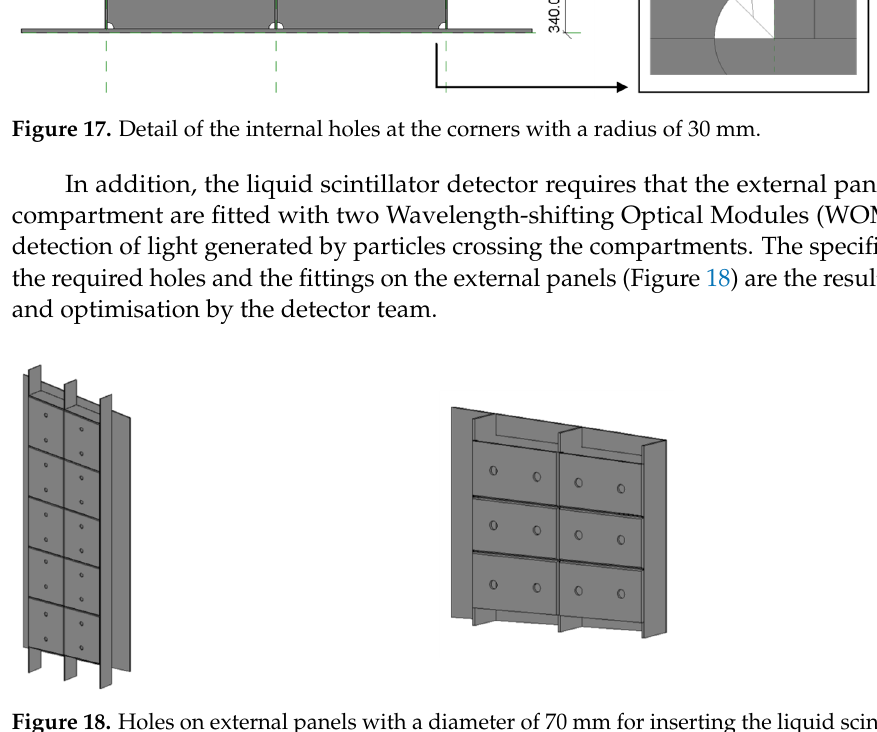
( c ) Figure 19. Joining between 2.4 m basic modules: ( a ) 2.4 m panels; ( b ) horizontal stiffening; ( c ) external panels.